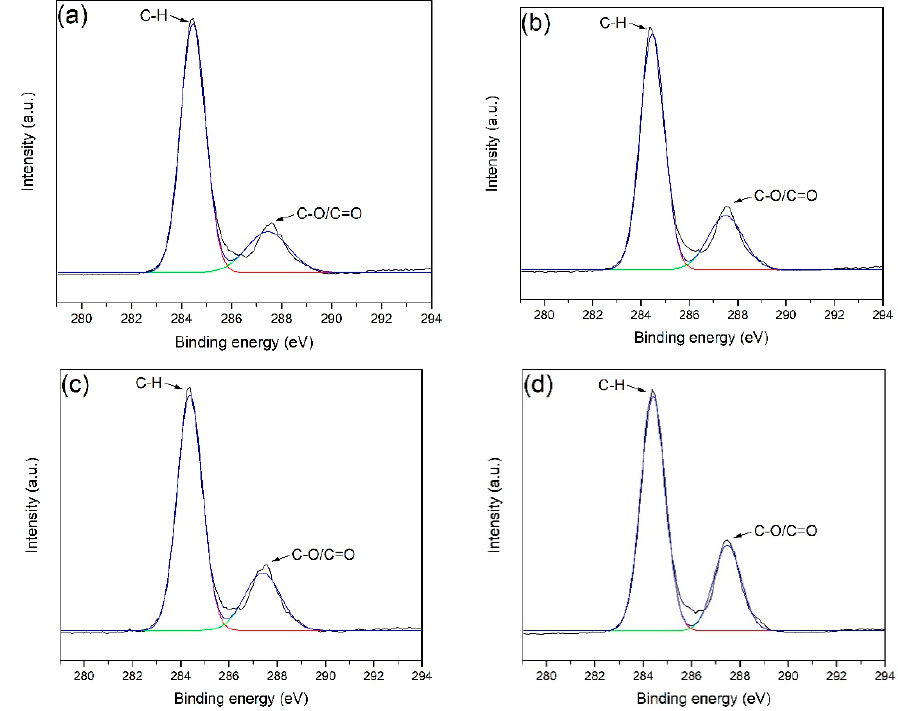
Figure 6. XPS spectra deconvolution of: the C1s peak of untreated POM fiber ( a ); and fiber subjected to DBD plasma treatment for: 30 s ( b ); 60 s ( c ); and 120 s ( d ). Table 3. Results of deconvolution analysis of C1s peaks for untreated POM fiber and fiber after DBD plasma treatment.